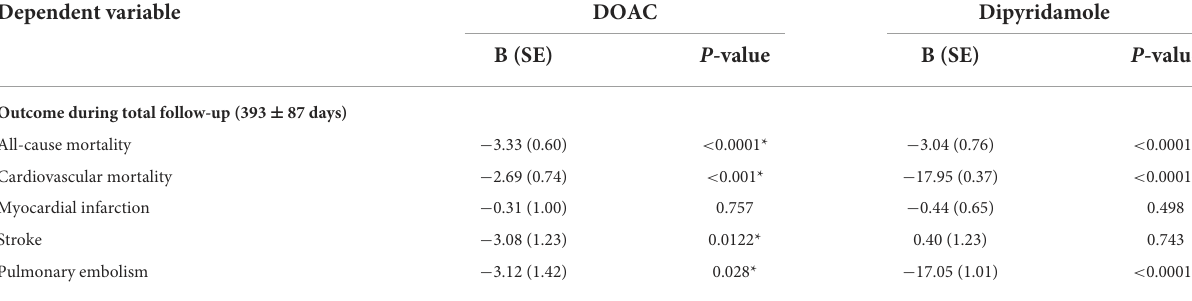
TABLE 3 Data of weighted binary logistic regression regarding the predefined study endpoints. Dependent